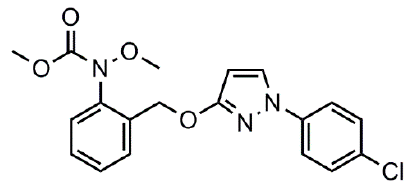
Figure 1. Chemical structure of pyraclostrobin.